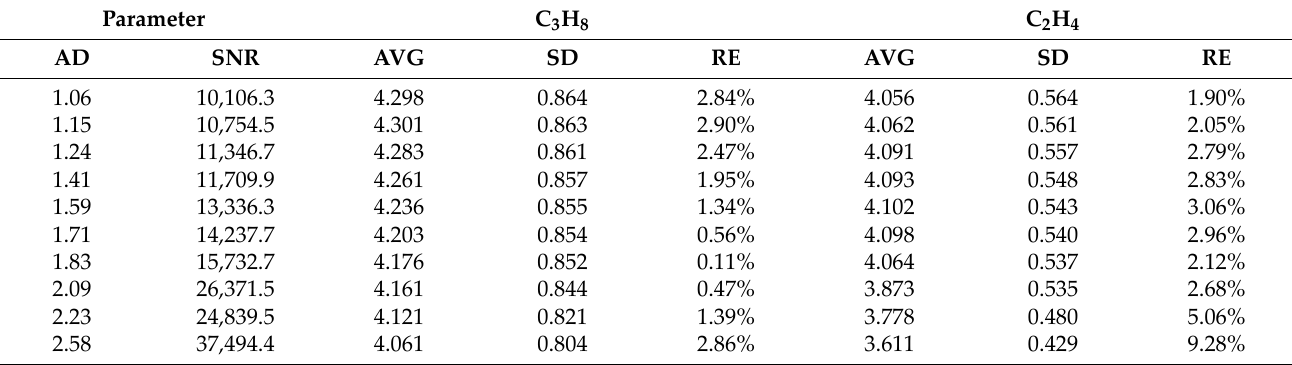
Table 8. Concentration inversion results of C 3 H 8 and C 2 H 4.